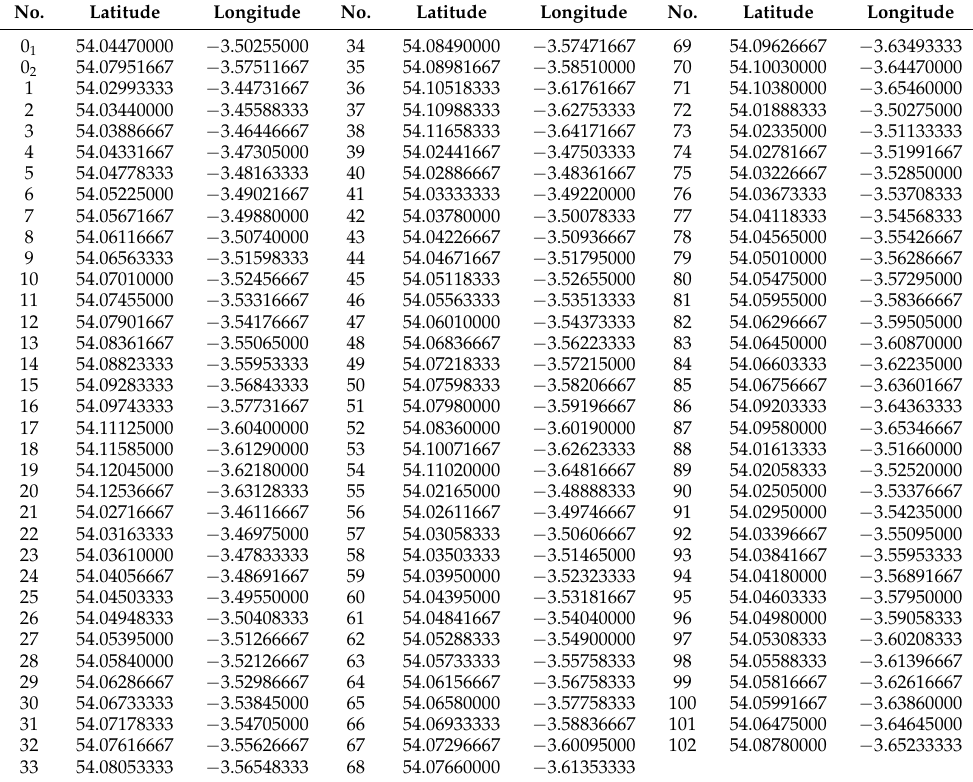
Table A1. WF-102-S2 wind farm coordinates (WGS84).